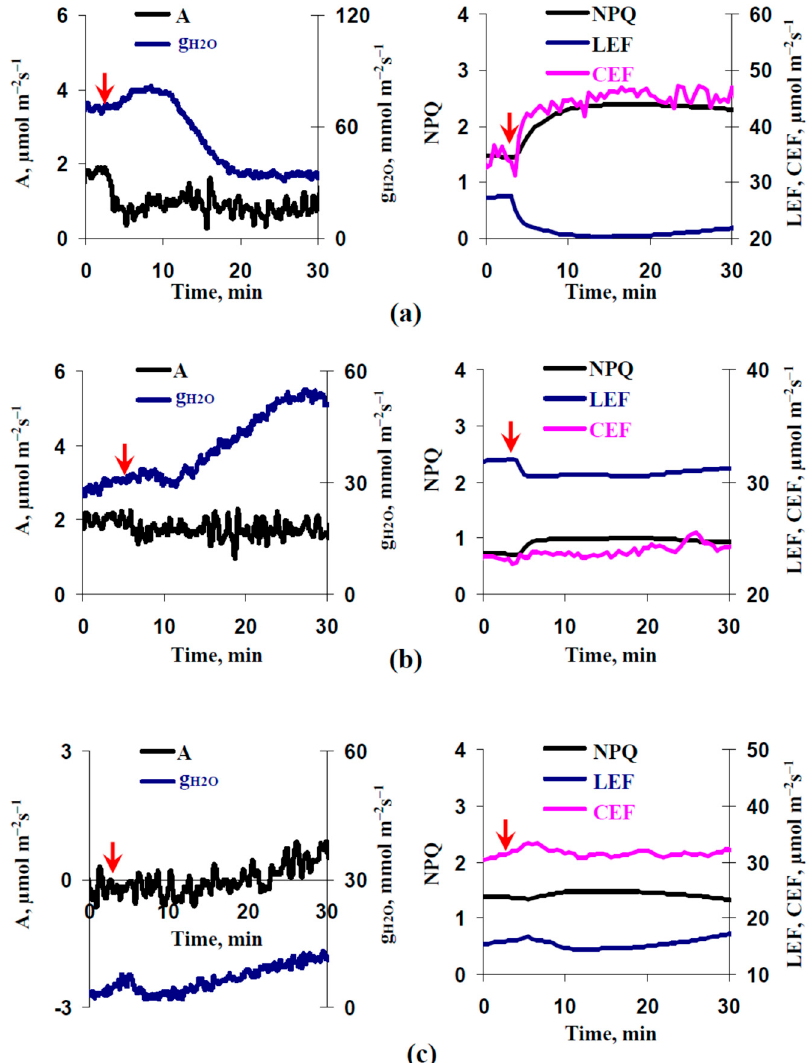
Figure 4. Records of burning-induced changes in CO 2 assimilation (A), leaf stomatal conductance (g H2O ), non-photochemical quenching (NPQ), photosynthetic linear electron flow (LEF), and cyclic electron flow around photosystem I (CEF) in control pea seedlings ( a ), seedlings after 2 days of soil water shortage ( b ), and seedlings after 4 days of this shortage ( c ) ( n = 6). Parameters were measured in the second mature leaf. Arrow marks the time of the burning of the first mature